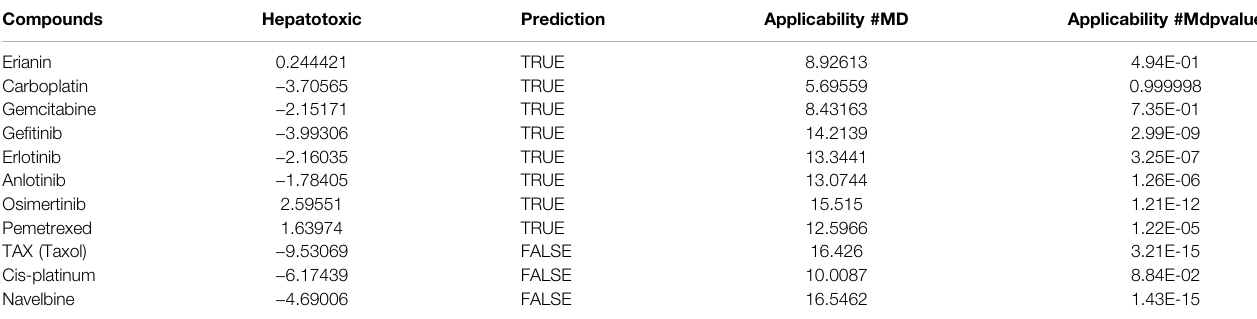
TABLE 6 | Hepatotoxicity prediction of erianin and reference drugs. Compounds